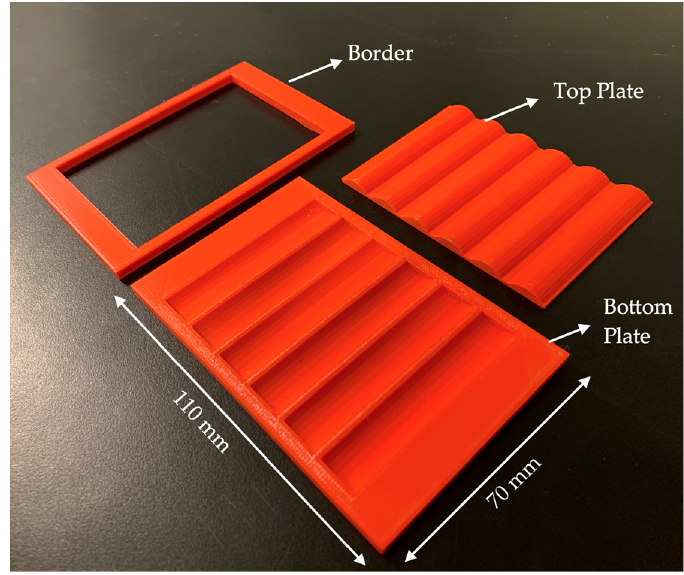
Figure 3. PEH housing-assembly components.